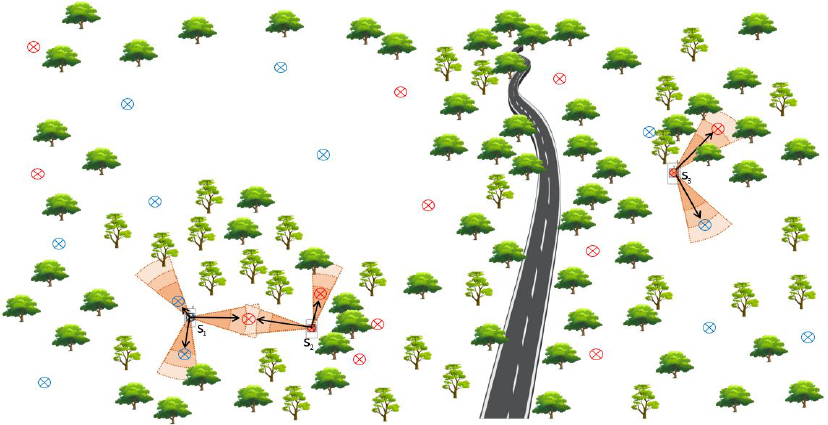
Figure 4. Forest